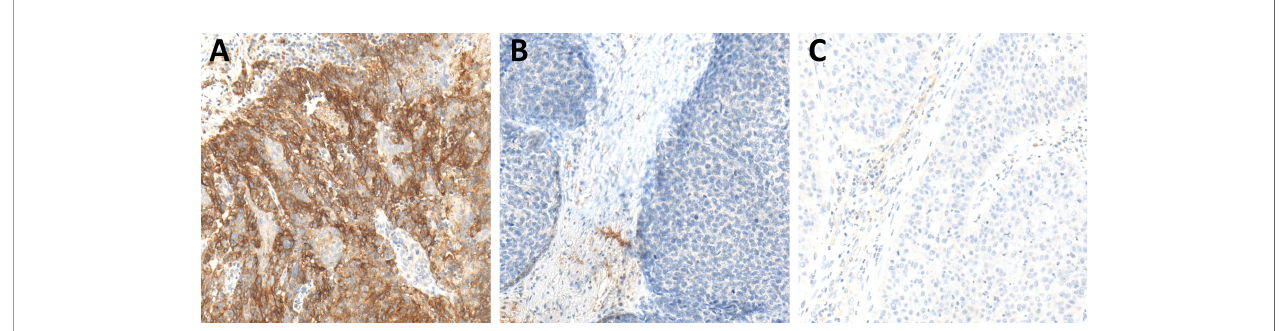
FIGURE 7 | Programmed death-ligand 1 (PD-L1) expression in hot (A) , cold (B) , and excluded (C) head and neck squamous cell carcinomas (HNSCCs). In hot HNSCCs (A) , the expression of PD-L1 was very high, while it was very low in cold (B) and excluded (C) HNSCCs.